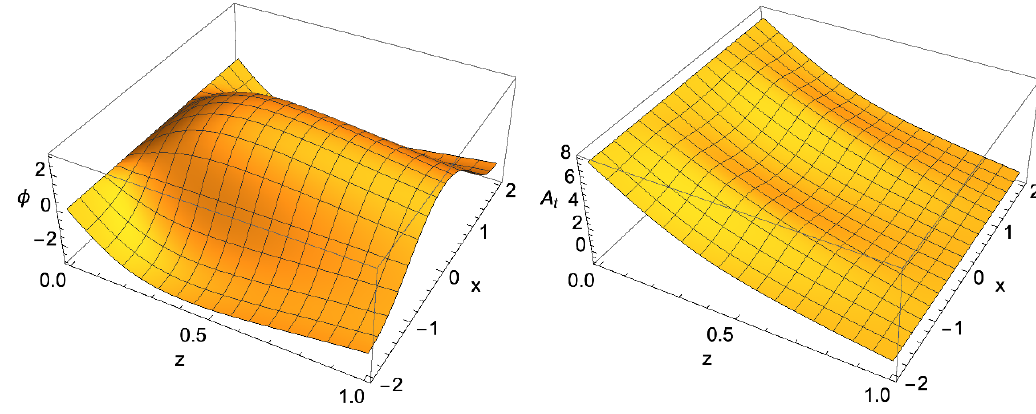
Figure 3 . Inhomogeneous con(cid:12)gurations of the bulk solutions of (cid:30) ( z; x ) (left) and A t ( z; x ) (right) with two nodes on the x -axis for (cid:22) = 7 : 5.